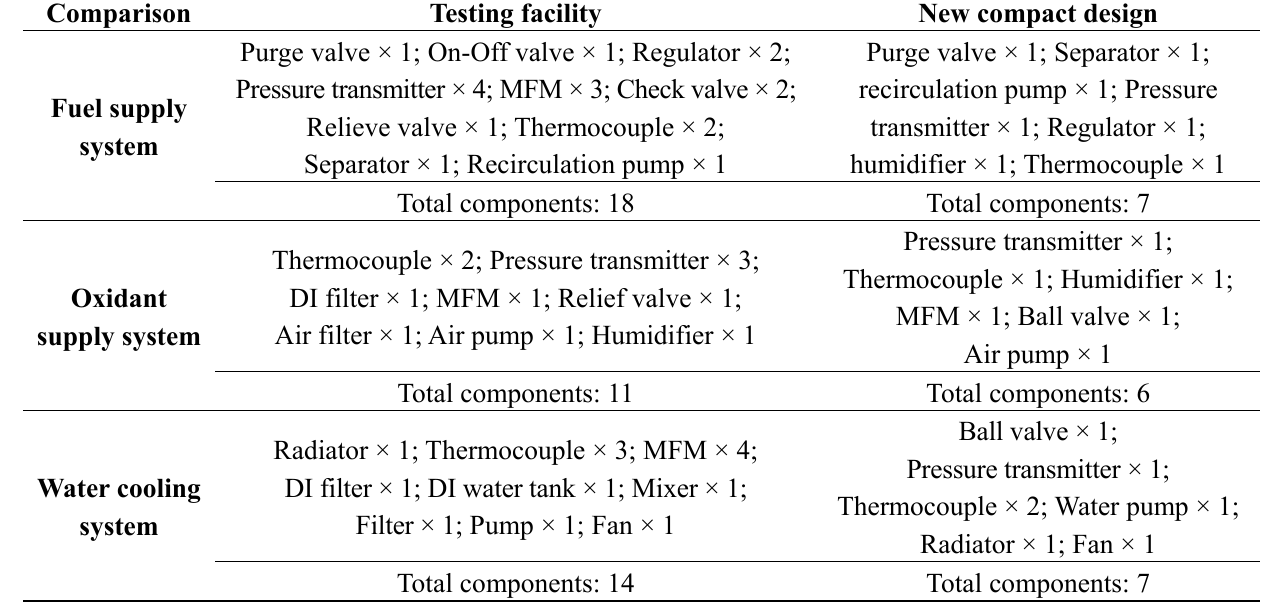
Table 1. Comparison of components used in the testing facility and new compact